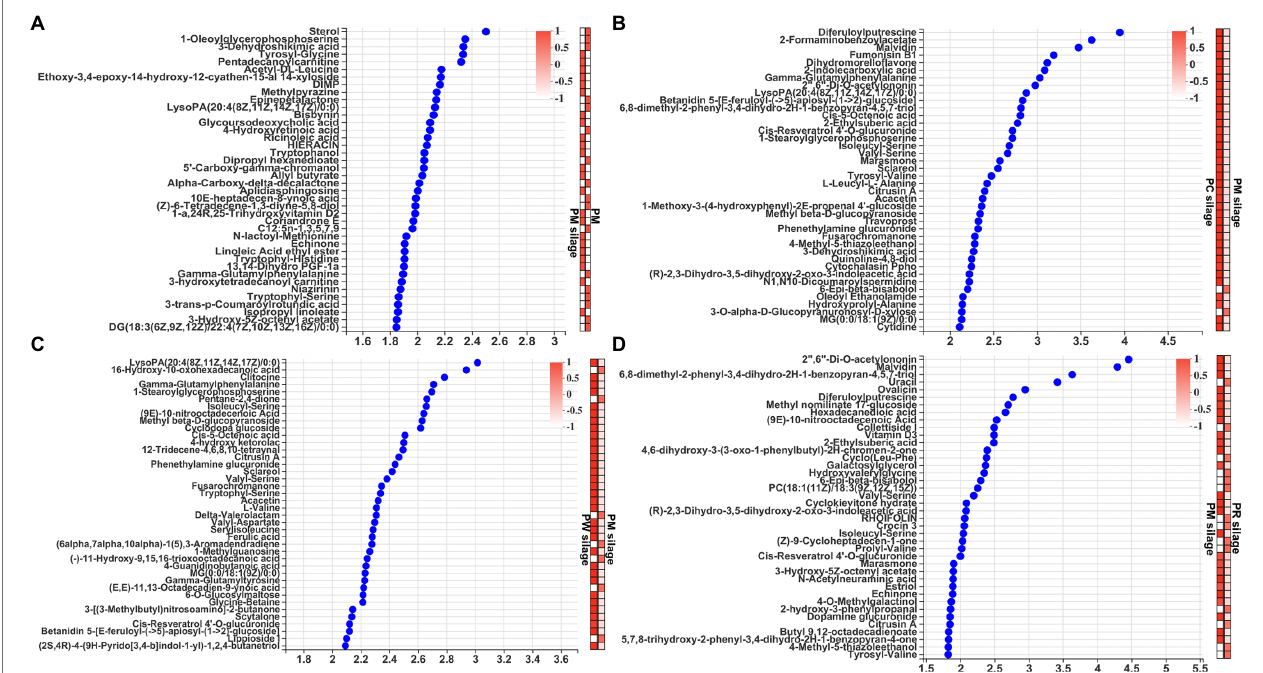
FIGURE 4 | Analysis of the difference of top 40 metabolites based on variable importance in projection (VIP) scores >1 among of the PM, CB, RB, WB material, and their silage: (A) the difference of metabolites by PM before and after ensiling; (B) the difference of metabolites by PM and PC silages; (C) the difference of metabolites by PM and PW silages; and (D) the difference of metabolites by PM and PR silages. PM, paper mulberry; CB, corn bran; RB, rice bran; WB, wheat bran; PC, PM +